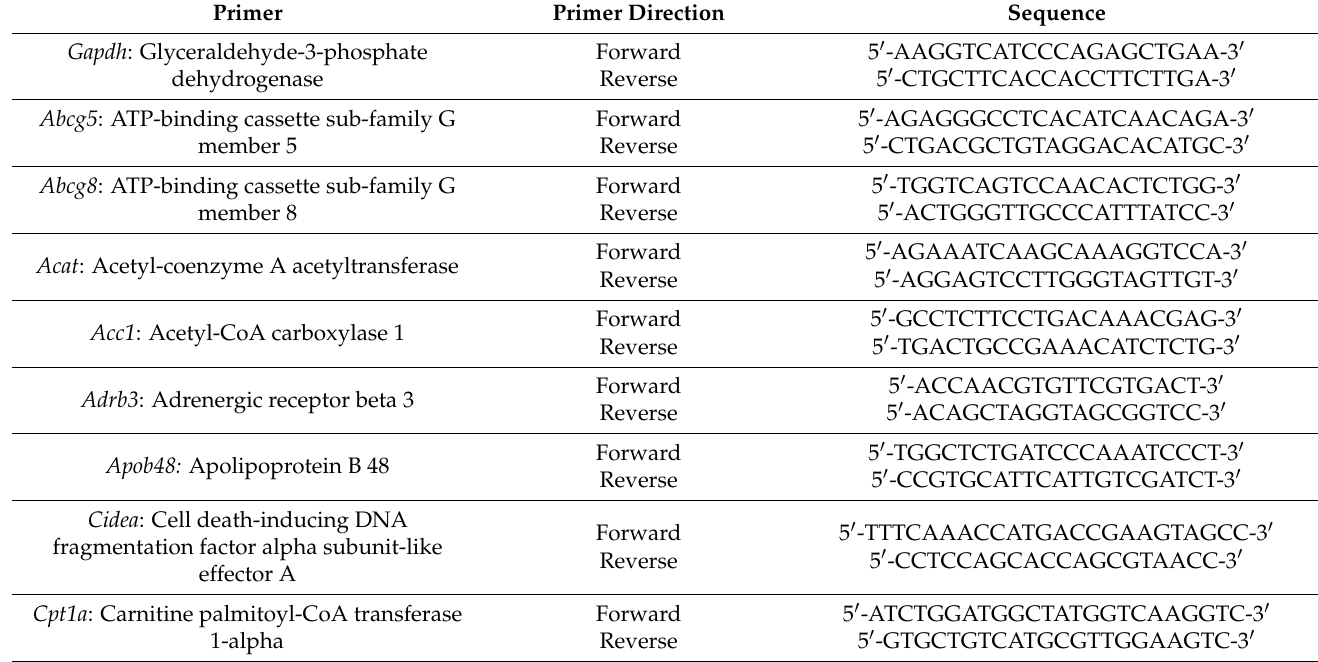
Table 2. Primer sequences used for